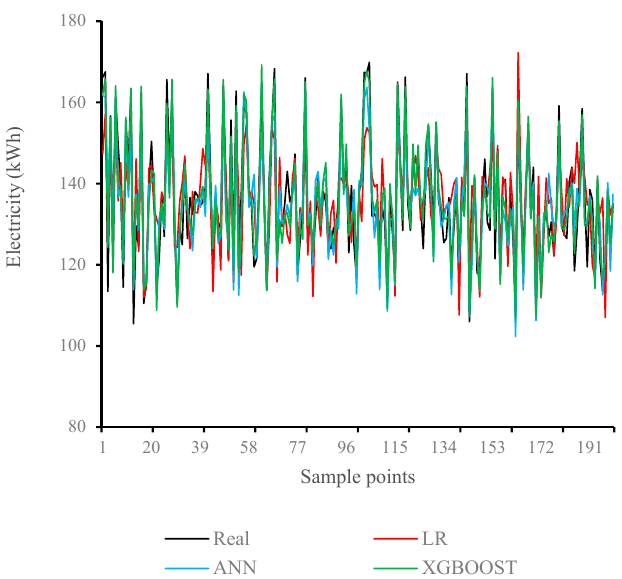
Figure 7. Real electricity consumption and predicted electricity consumption.